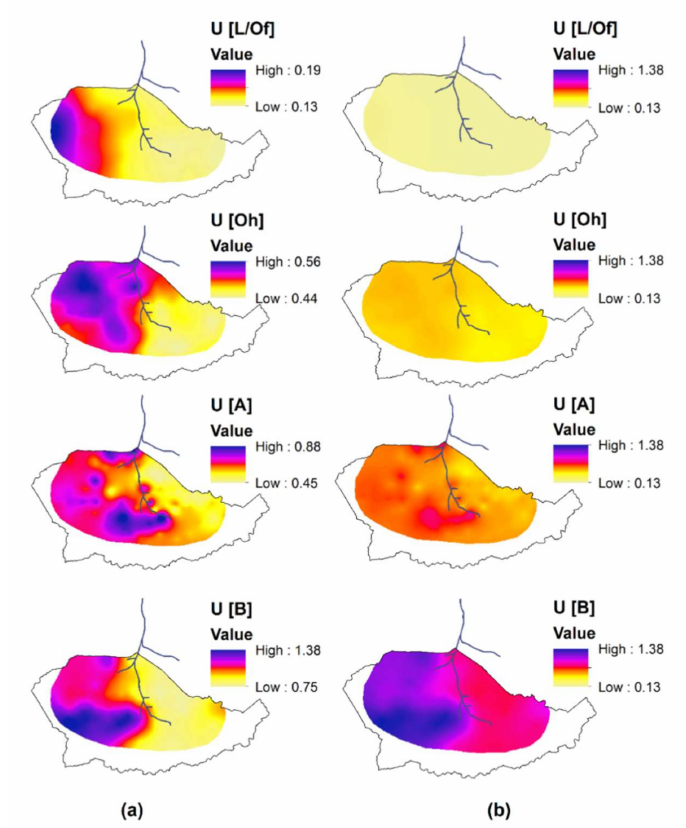
Figure 3. Spatial distribution of U in the catchment area for the four principal soil horizons (L / O f , O h , A, and B, top to bottom rows) using ordinary kriging, represented using ( a ) di ff erent color bars, and ( b ) one color bar for all horizons. Notice the individual legend for each horizon for U (mg kg − 1 ) concentration distributions. Extreme outliers were identified in R (Version 3.3.2, R Core Team, Vienna, Austria) by setting the upper and lower limits as the quartile (lower or upper) plus or minus three times the inter quartile